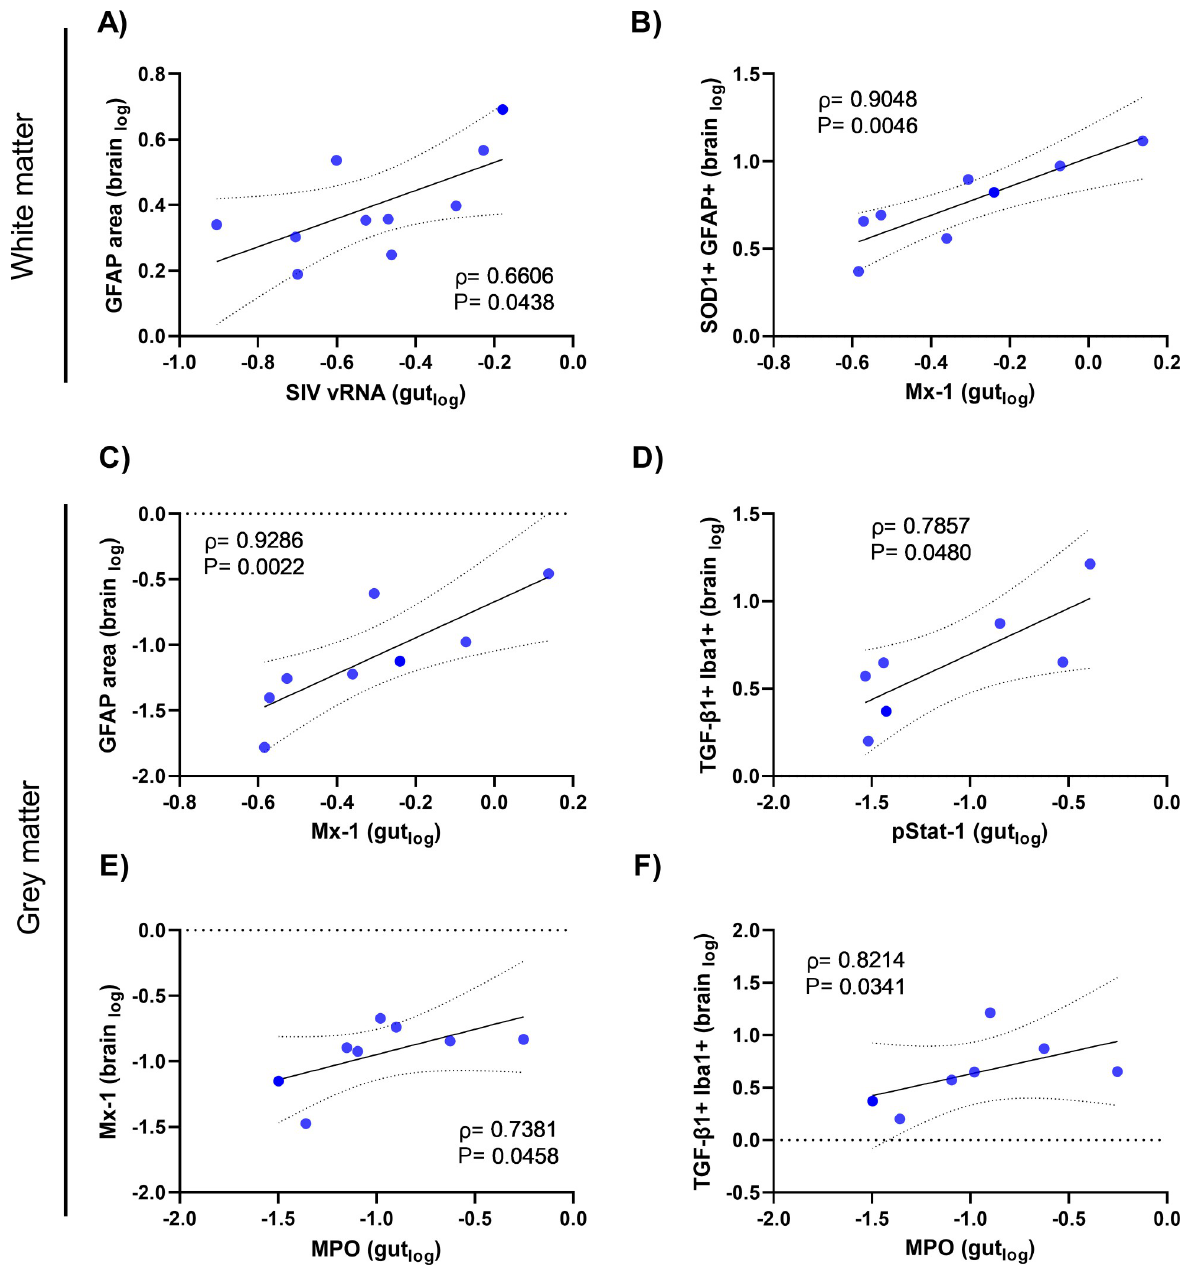
Fig 6. SIV RNA, type I interferon responses and barrier damage in the gut are associated with immune activation in the frontal cortex of virally suppressed SIV+ animals. Correlative analysis of levels of immune activation markers in white matter (WM) or grey matter (GM) from frontal cortex tissue of virally suppressed SIV+ animals (n = 7–10), as determined by IHC, to levels of (A) SIV viral RNA, (B and C) Mx1, (D) pSTAT1 or (E and F) myeloperoxidase (MPO)+ cells from matched gut tissue. Parameters were log transformed. Spearman rho and P values shown. P < 0.05 considered statistically